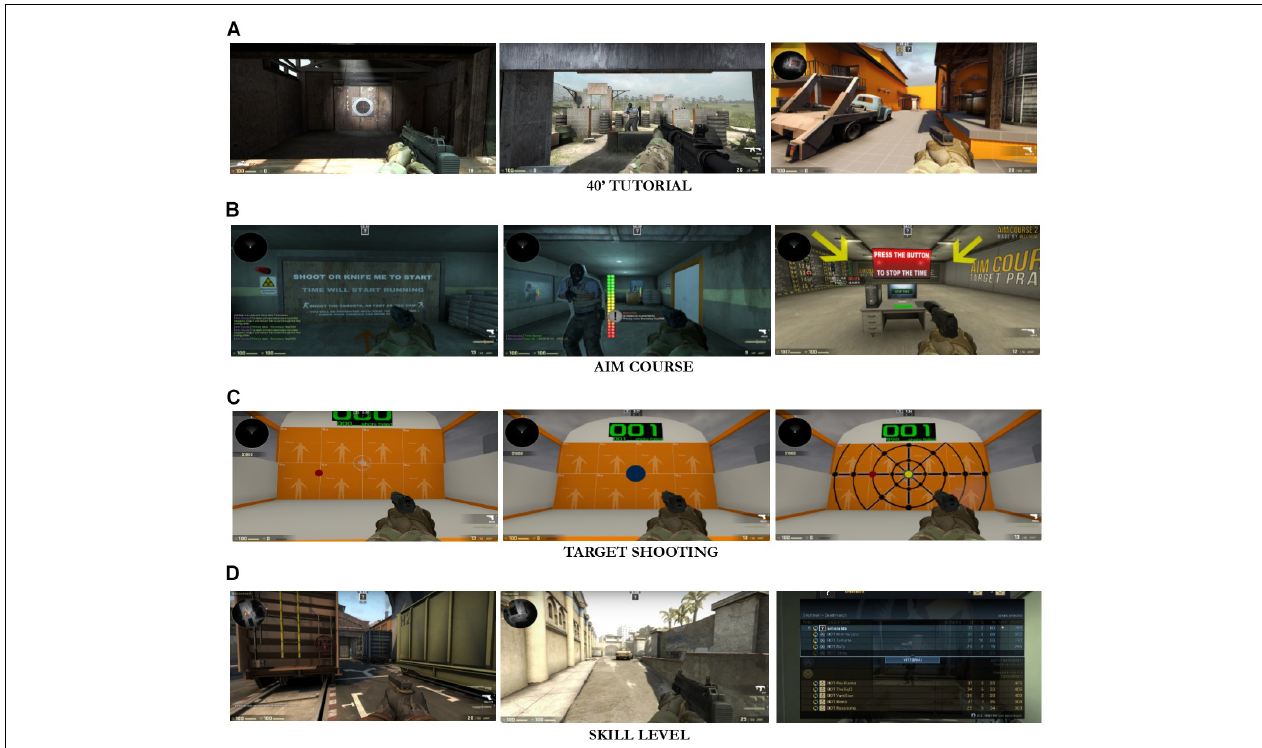
FIGURE 2 | Game skills assessment. (A) During the initial assessment, each player completed 40 (cid:48) of tutorial to understand the game controls and the environment. (B) At T0 and T1, subjects completed the Aim Course time-constrained task. The times required to complete the Aim Course 1 and Aim Course 2 Maps were registered. (C) At T0 and T1, the participants engaged in various shooting tasks and accuracy was recorded. (D) At the initial assessment, the A-CS:GO group was further assessed on a fourth task, aiming to define the level of player game-ability. This task established the player’s starting level.